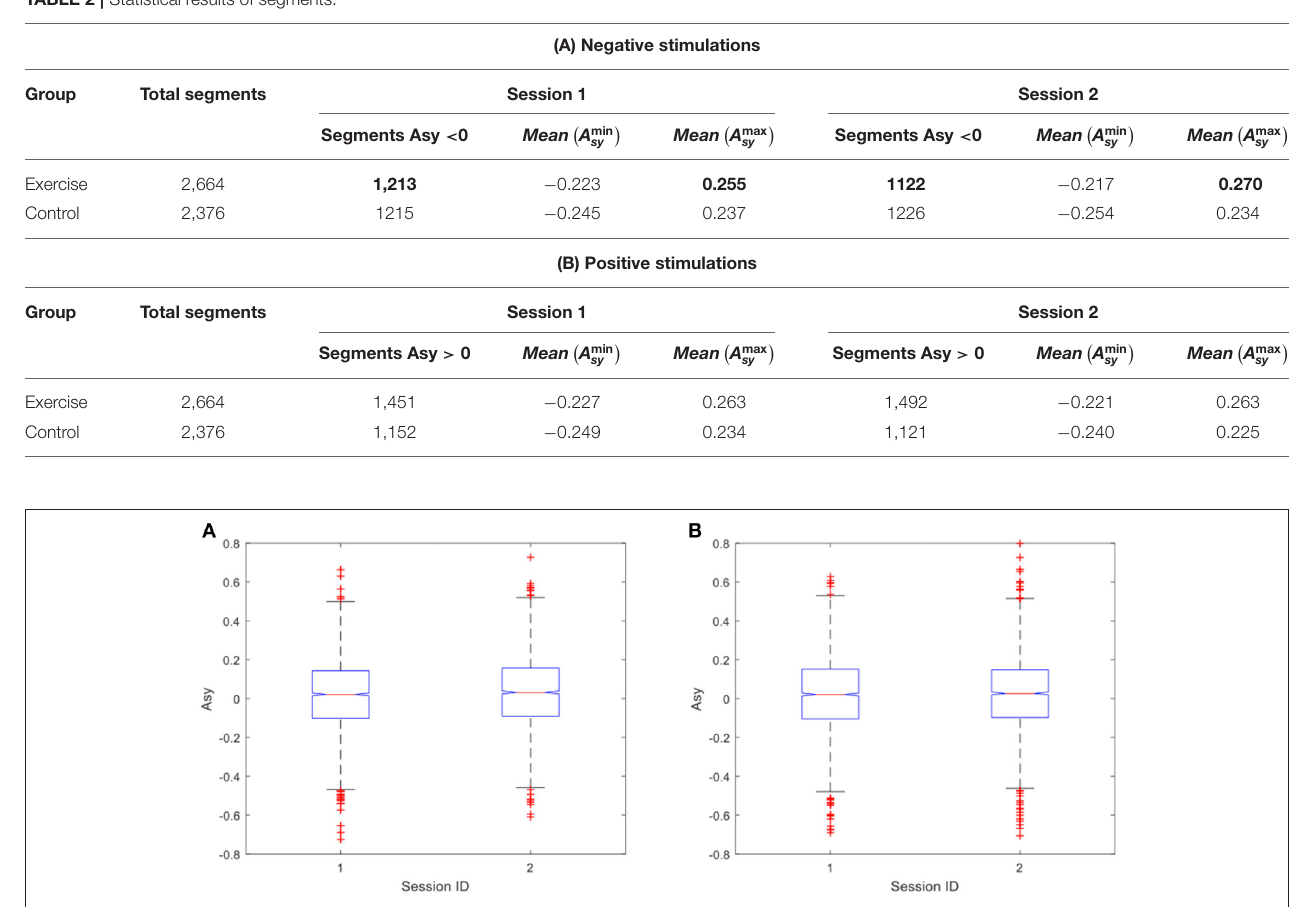
FIGURE 6 | (A) Difference in Asy for negative stimulations ( p = 0.0254) in the exercise group; (B) Difference in Asy for positive stimulations ( p = 0.3361) in the exercise group. Here, session ID = 1 is the pre-exercise session and session ID = 2 is the post-exercise session.